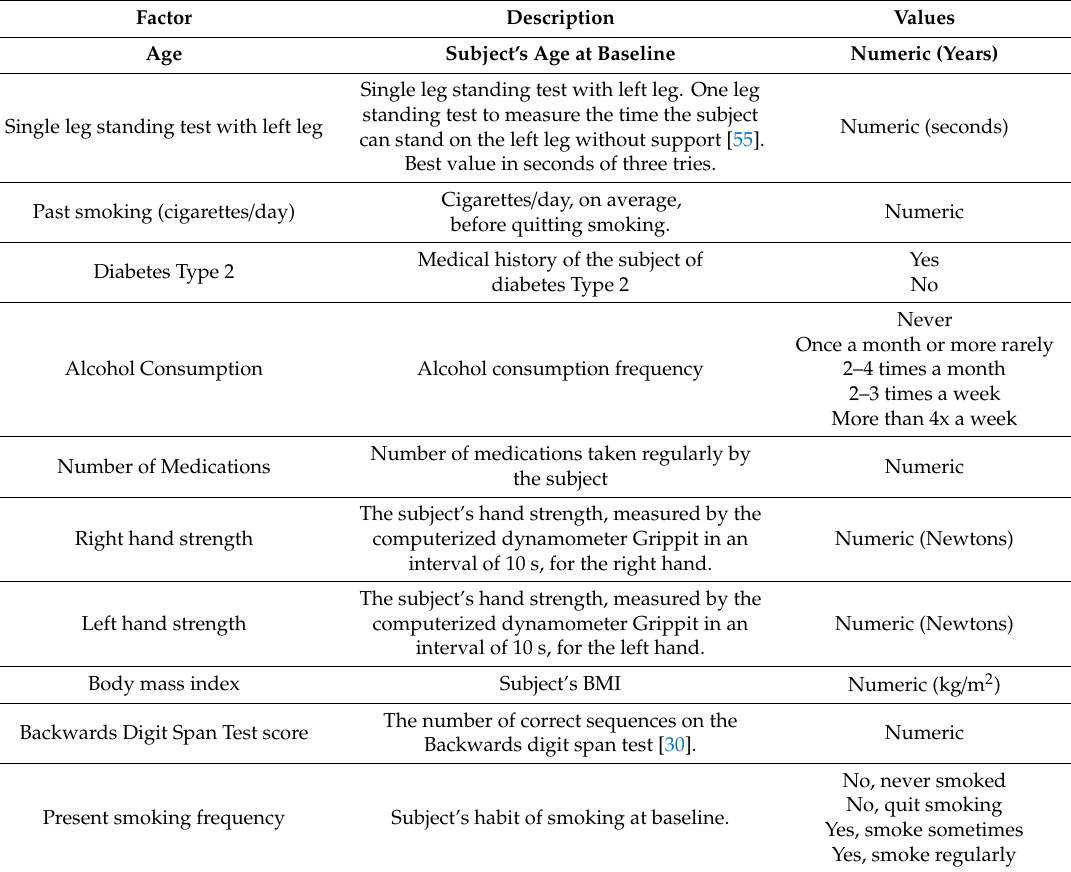
Single leg standing test with left leg. One leg standing test to measure the time the subject can stand on the left leg without support [55]. Best value in seconds of three tries.